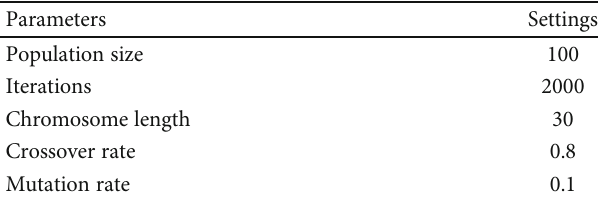
Table 4: Genetic algorithm